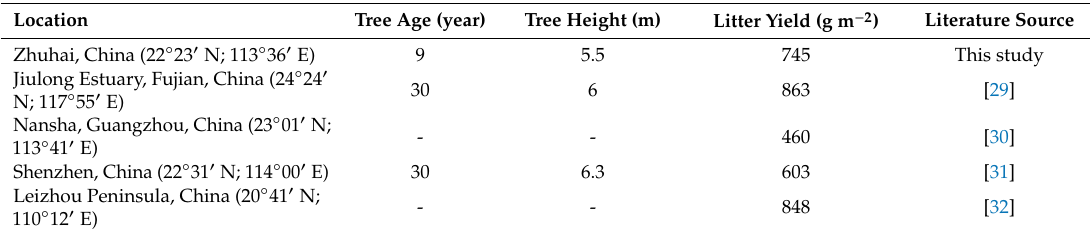
Table 4. A comparison of annual litter yield of Heritiera littoralis at di ff erent locations along the South China coast.